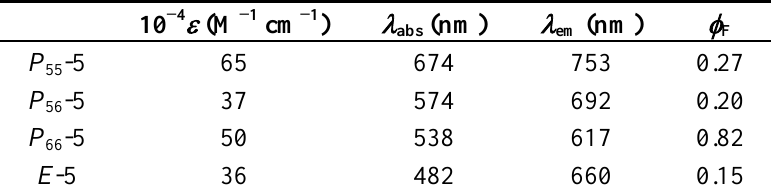
-5 , P -5 , and P -5 in 55 56 66